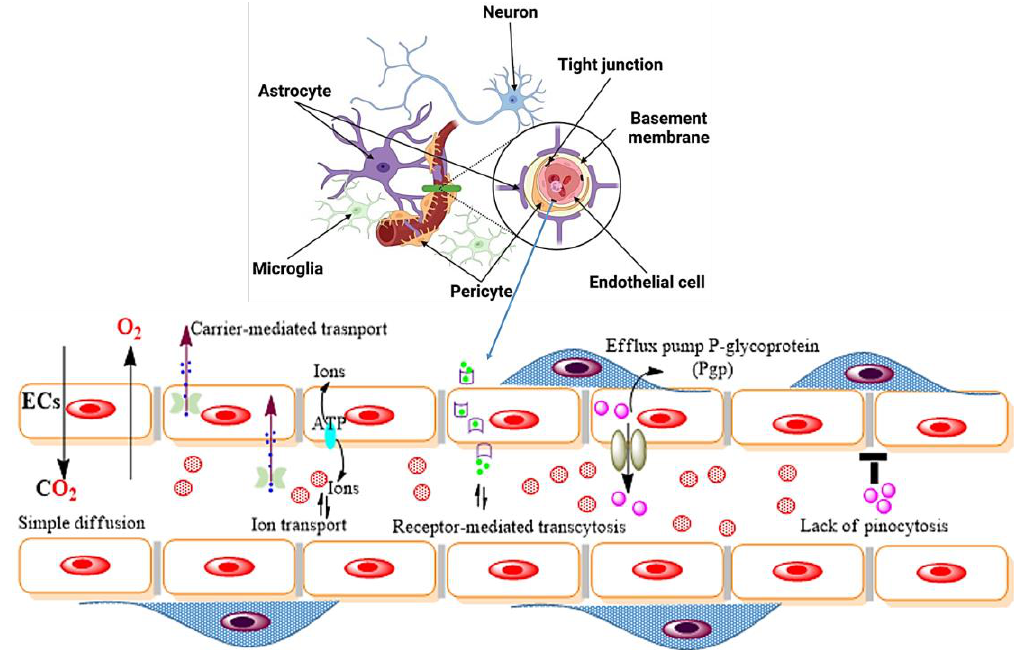
Figure 2. Schematic representation showing the various modes of transport system across the BBB includes carrier-mediated transport (CMT), receptor-mediated transport (RMT), efflux transporters, and ion transport, which are mainly governed by specialized endothelial cells of the